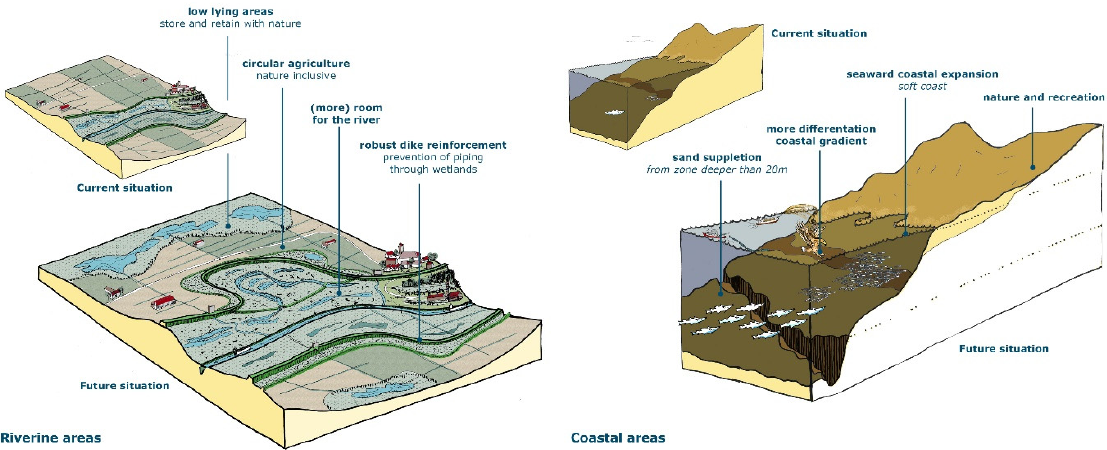
Figure 1. Typical river landscape (left) and coastal landscape (right) in the Netherlands in 2020 (top) and the vision for the future in 2120 (bottom). Source [12].